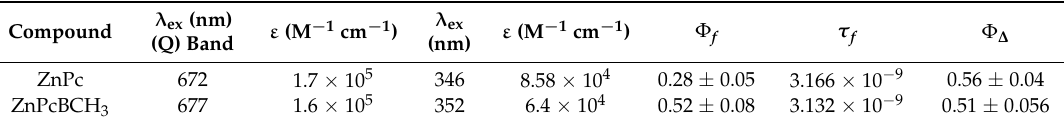
Table 1. Photophysical properties of ZnPc and ZnPcBCH 3 in DMSO obtained in plate reader with correction factor of 0.32.